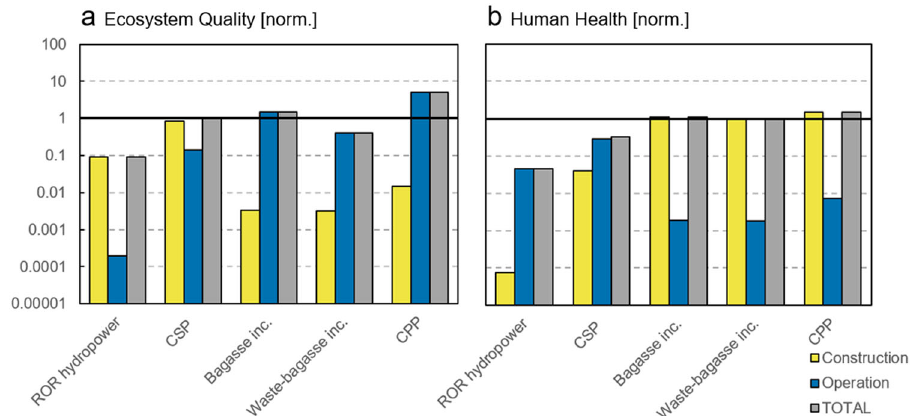
Fig. 4 Environmental impacts of electricity generation systems. Results are presented by indicators a , b for the construction (yellow bars) and operation (blue bars) phase, respectively, on a logarithmic scale (details Fig. 2). ROR run-of-river, CSP concentrated solar power plant, Bagasse inc. Bagasse incineration, CPP coal- fi red power